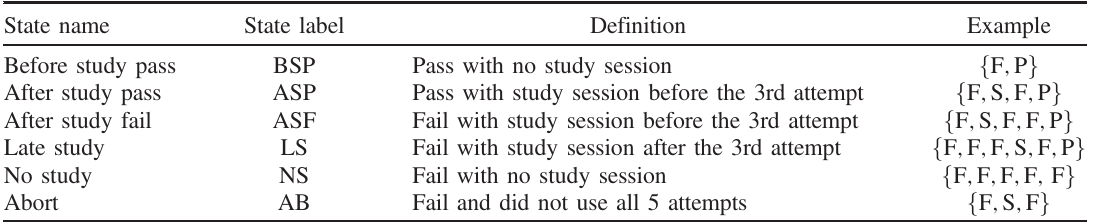
TABLE I. Definition of level II states. Note that “ fail ” states are defined as failing the first three attemps on each module. The example column presents the most common event sequence for each